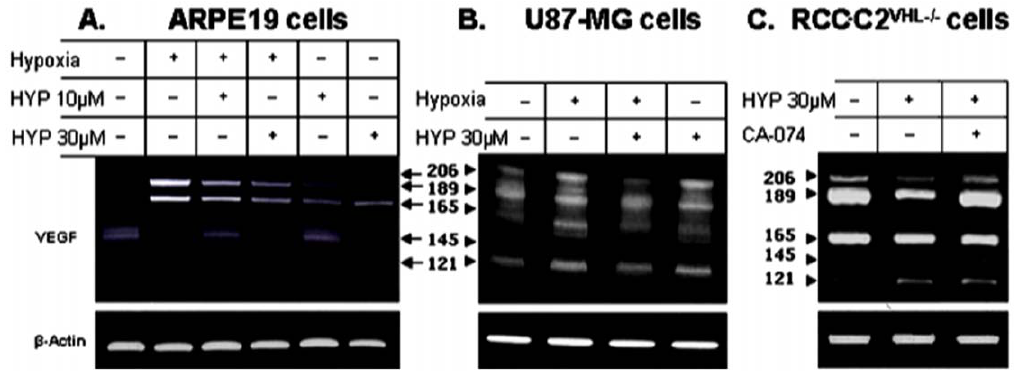
Figure 3. Modulation of expression patterns of the different VEGF-A splice variants by cell treatment with hypericin. A. In ARPE-19 cells, B. in U87-MG cells and C. in C2 VHL 2 / 2 cells.